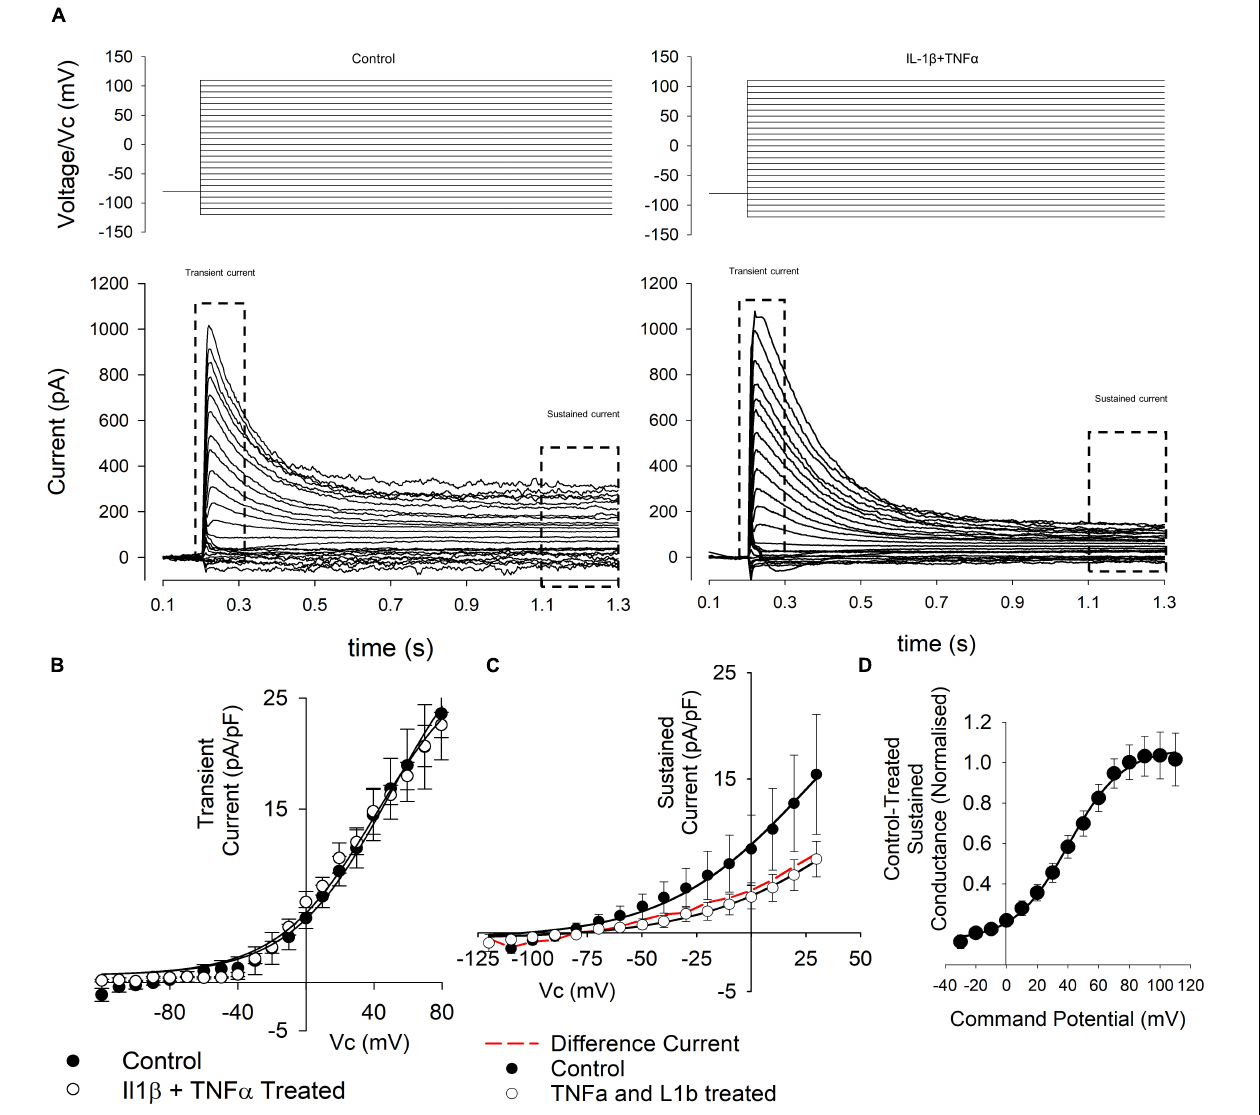
FIGURE 5 | Whole-cell voltage-gated currents from control and cytokine treated FLS. (A) Top panels show the voltage step protocols and the evoked currents are shown below for control (left) and IL1 β + TNF α (right) conditions. Note that FLS exhibit both transient and sustained currents. These phases of current were then analyzed separately as indicated. (B) Current–voltage curves (left) from the transient currents recorded in a number or experiments such as that illustrated in (A) . There was no significant difference between control and treated transient current density. Data points are shown as mean ± SEM ( n = 18 for control and n = 11 for IL1 β + TNF α ). (C) Current–voltage curves from the sustained currents recorded in a number or experiments such as that illustrated in (A) . The red line in the current–voltage curve is the difference current for control-cytokine treated. (D) Difference conductance–voltage curve for the cytokine difference current shown in (C) . The line is fit with a Boltzmann, see text